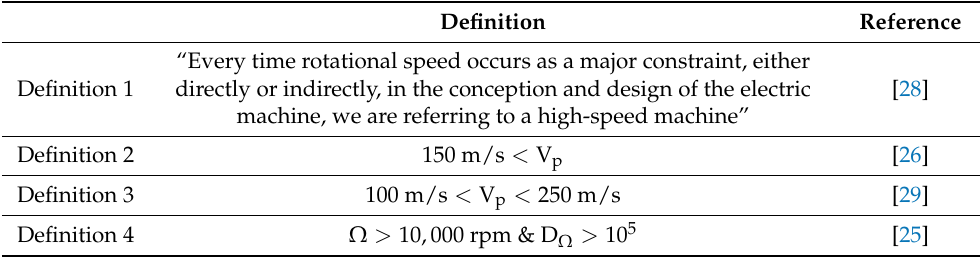
Table 1. Definitions of high-speed machines in the